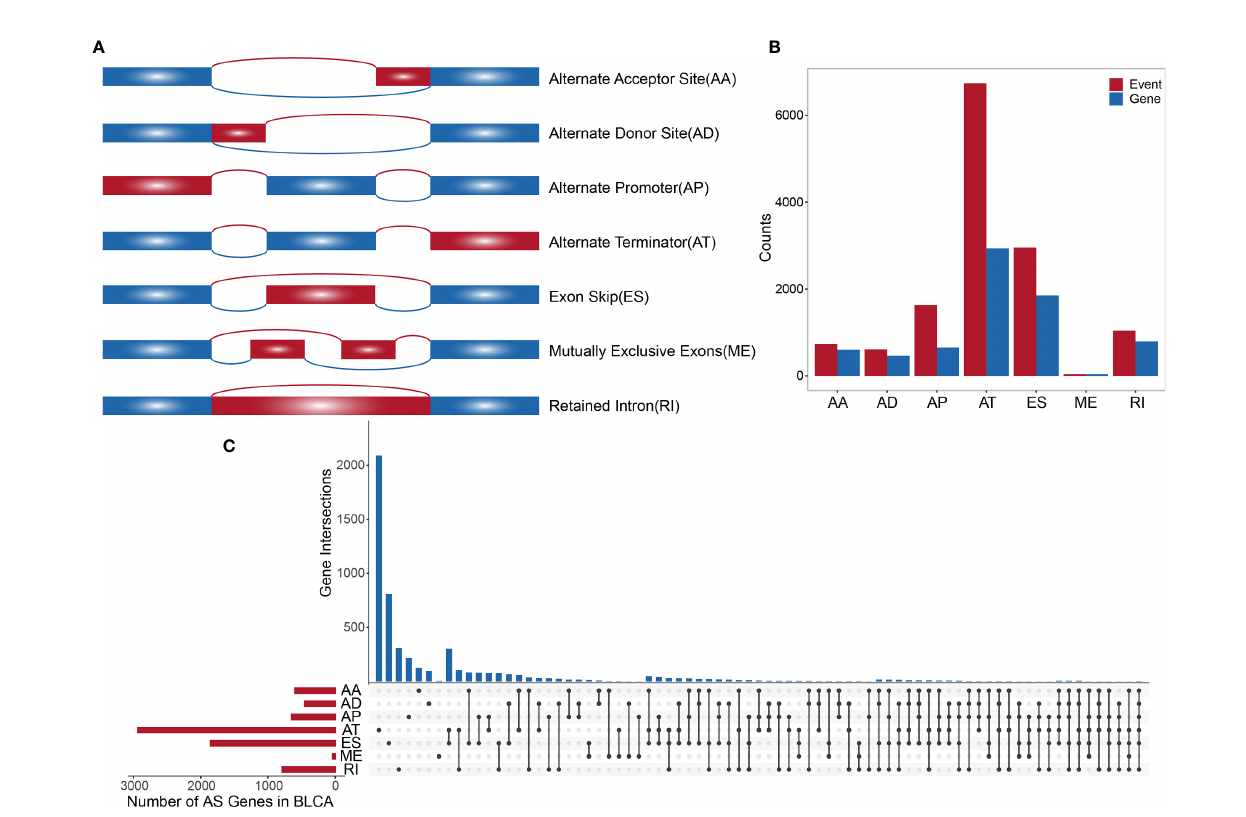
FIGURE 1 | (A) Schematic diagram of AS. (B) Histogram of overall AS events and the number of genes involved. (C) The UpSetR plot showing the relationships between overall AS event-related genes across different